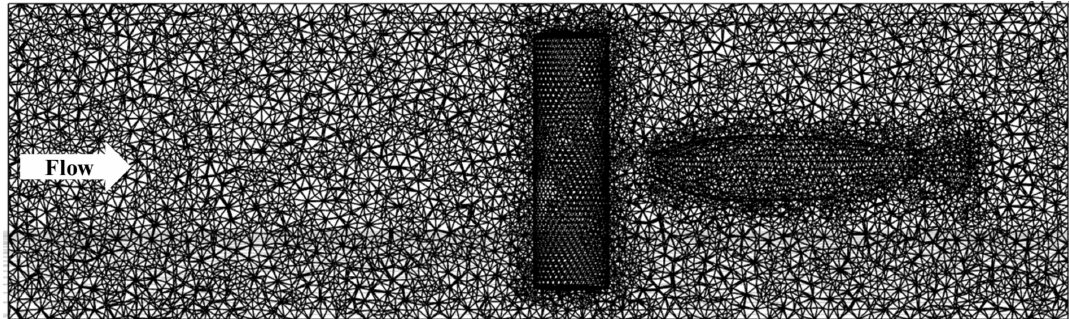
Figure 3. Mesh distribution on the plane of symmetry (side view).